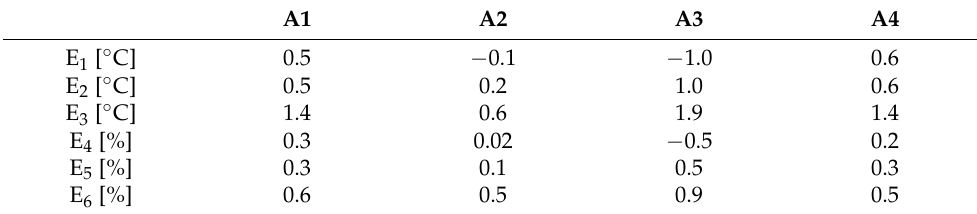
Table 6. Values of estimates E 1 –E 6 for temperature (14)–(19), with heating process p5, in planes A1–A4. A1 A2 A3 A4 E 1 [ ◦ C] − 0.1 − 1.0 − 1.9 3.0 E 2 [ ◦ C] 0.5 1.0